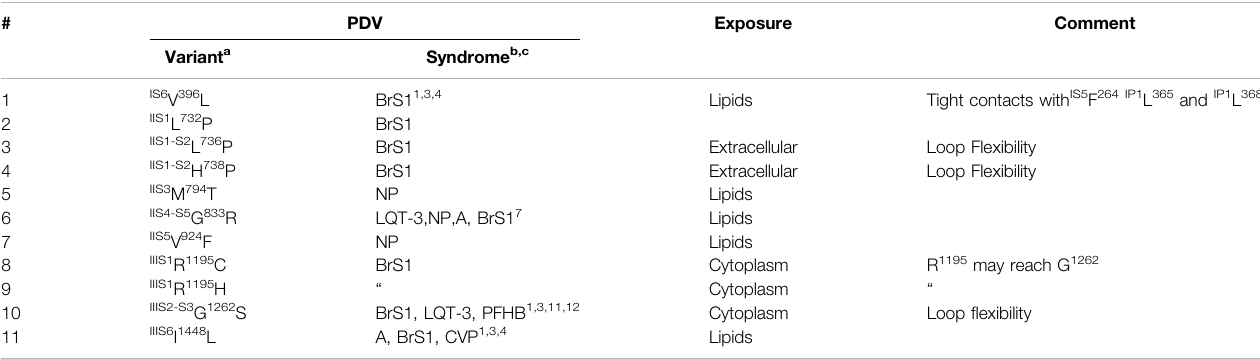
TABLE 6 | PDVs whose missense contact variants in the cryo-EM structure or models are not listed in